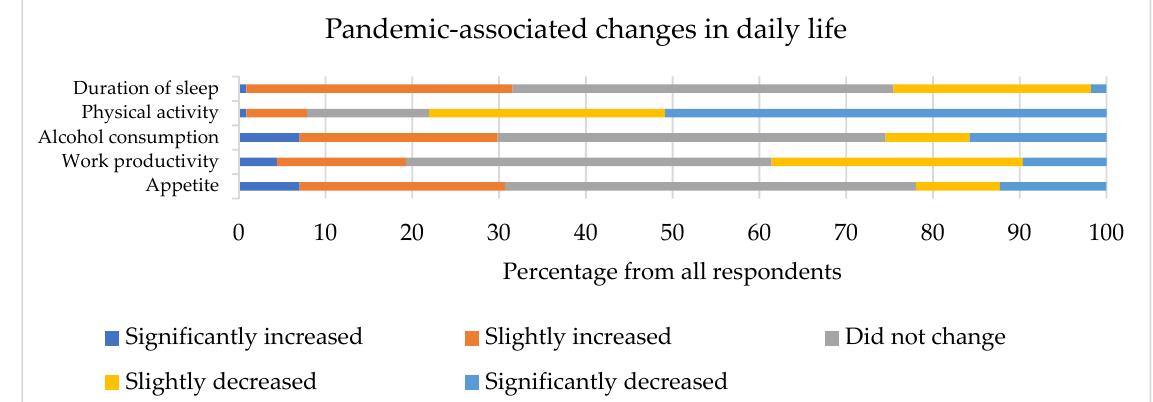
Figure 2. Changes in respondents’ daily lives during the COVID-19 pandemic. According to the GAD-7 questionnaire data, 25.4% of respondents experienced mod- erate to severe levels of anxiety ( ≥ 10 points). A higher consumption of alcohol and reduced physical activity during the pandemic correlated with symptoms of anxiety (r s = 0.187, p = 0.046; r s = − 0.186, p = 0.048, respectively). Questions from the WHO-HPQ questionnaire revealed that respondents’ work per- formance during the previous 4 weeks was, on average, equal to 80% of their best possible performance. The evaluation of absenteeism indicated that respondents did not lose any working hours during the previous 4 weeks (median = 0, range from − 90 to 125). Forty- seven (41.2%) respondents claimed that they worked more than expected. The measure of presenteeism correlated with daytime dysfunction due to sleepiness (absolute presentee- ism: r s = − 0.207, p = 0.027) and sleep latency (absolute presenteeism: r s = − 0.188, p = 0.045). Absenteeism was related to daily screen use (4-week absolute absenteeism: r s = − 0.233, p = 0.013; 4-week relative absenteeism: r s = − 0.227, p = 0.015) and medium-intensity physical activity (4-week absolute absenteeism: r s = 0.188, p = 0.045; 4-week relative absenteeism: r s = 0.182, p = 0.052). A stepwise linear regression model for PSQI was created by including variables that were previously found to correlate with the PSQI score (F(5108) = 11.457, p < 0.001, R 2adj = 0.316). A respective model with 4-week relative absenteeism as the dependent variable (F(2111) = 7.570, p = 0.001, R 2adj = 0.104) included self-reported productivity during the COVID-19 pandemic, the number of screen hours per day, and the time spent in medium- intensity training (the latter variable was included as its correlation with the measure of absenteeism approached statistical significance). The number of daily screen hours was excluded from the model during stepwise selection ( p = 0.09). A summarized model of the regression models is presented as a path analysis in Figure 3.